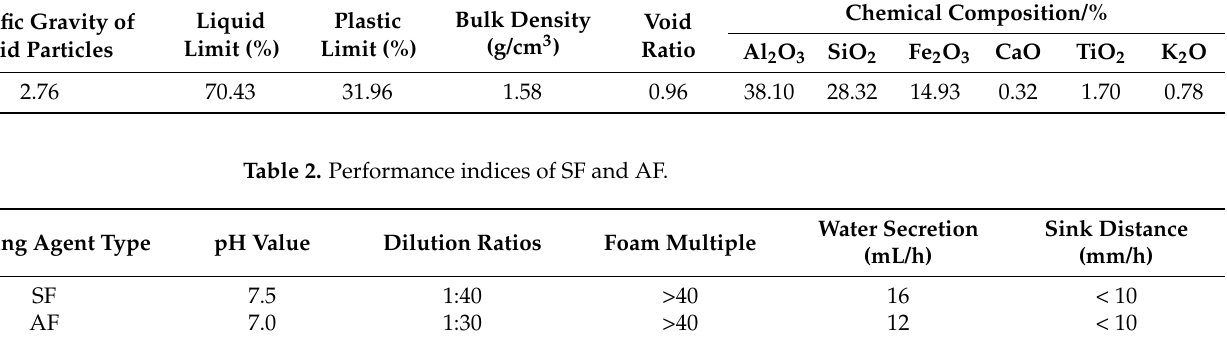
Table 3. Chemical composition and mineral composition of BTs.